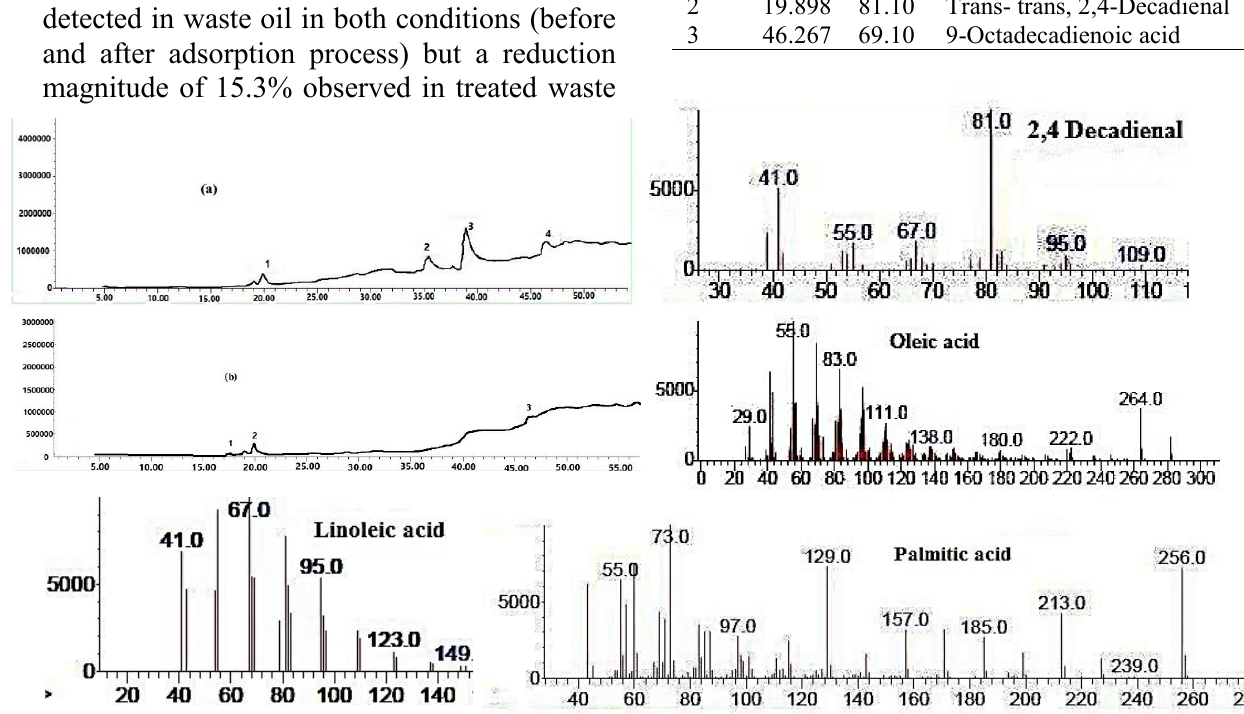
Fig. 2. Chromatogram of untreated (a) and treated oil (b).